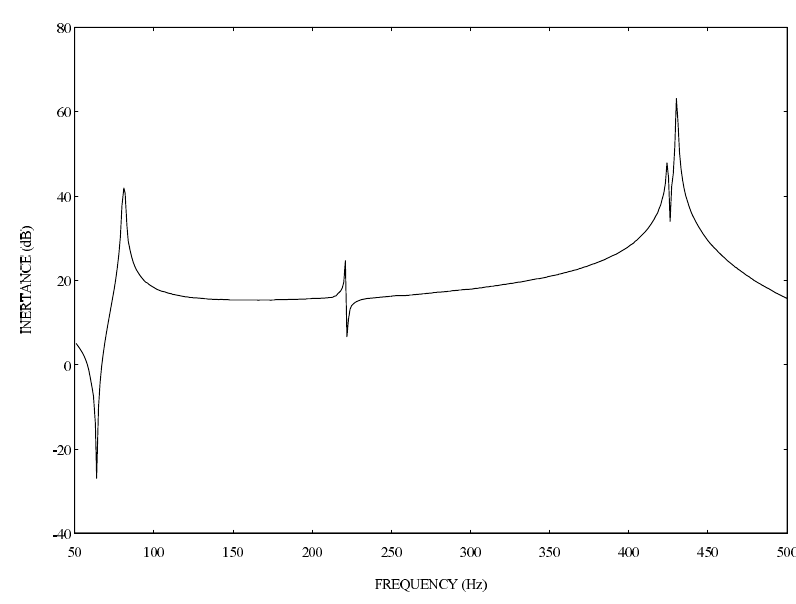
Fig. 3. Frequency response of primary